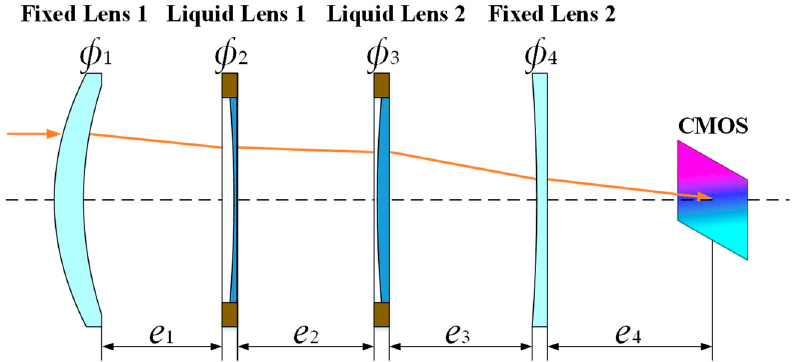
Figure 1. Optical layout of the zoom system.